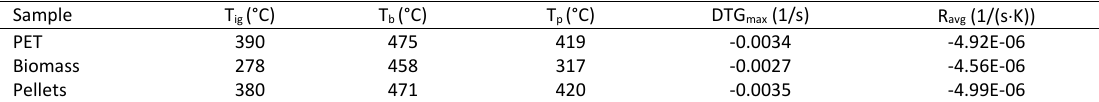
Table 6: Thermal decomposition of samples in combustion at 15 °C/min Sample